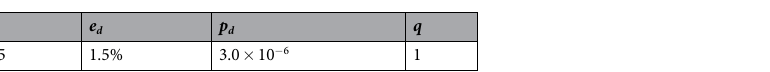
Table 2. System parameters used in numerical simulations of QKD: e 0 : error rate of vacuum count, e d : misalignment-error probability; p